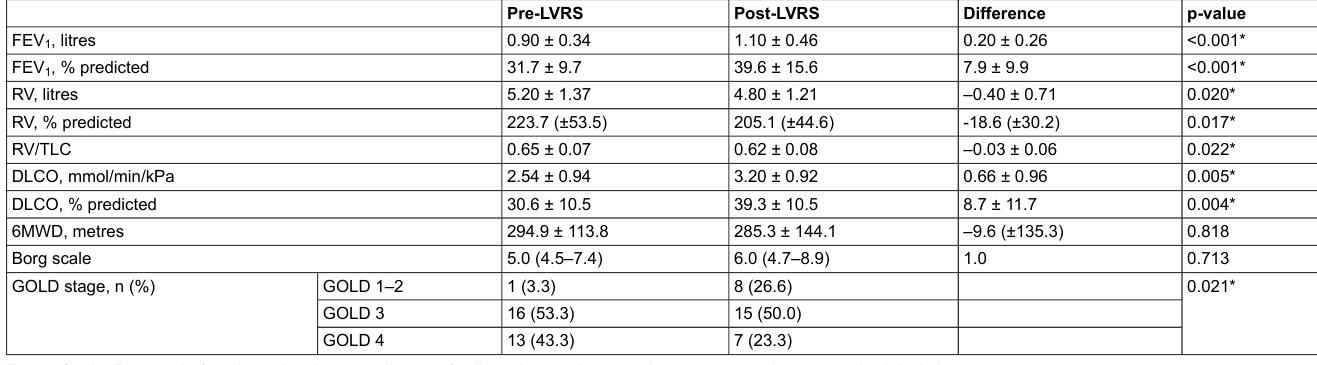
Table 2: Change in clinical effectiveness data at 102.5 ± 22.8 days after lung volume reduction surgery.